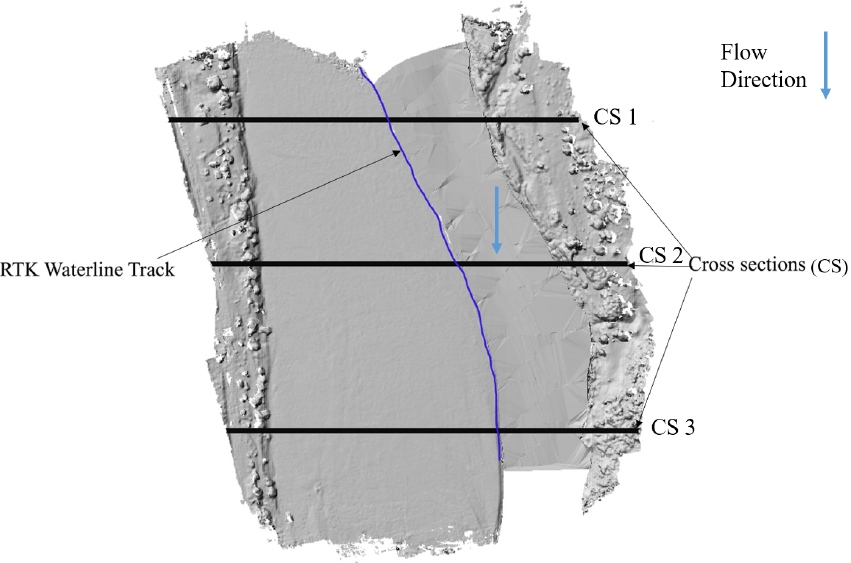
Figure 9. The location of three cross sections (CS1, CS2, and CS3).